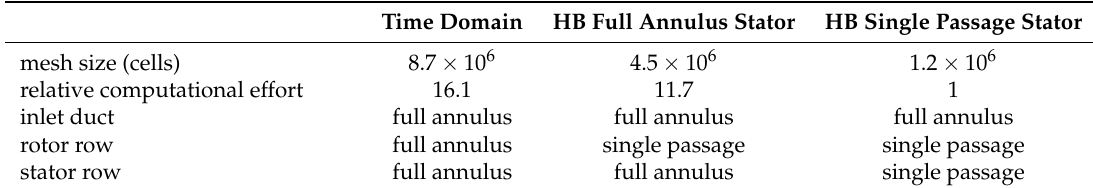
Table 2. Numerical setups and computational efforts for time-domain and HB simulations.